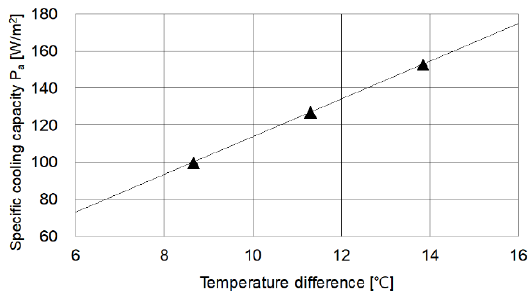
Table 18. Nominal cooling capacity of CRCP.